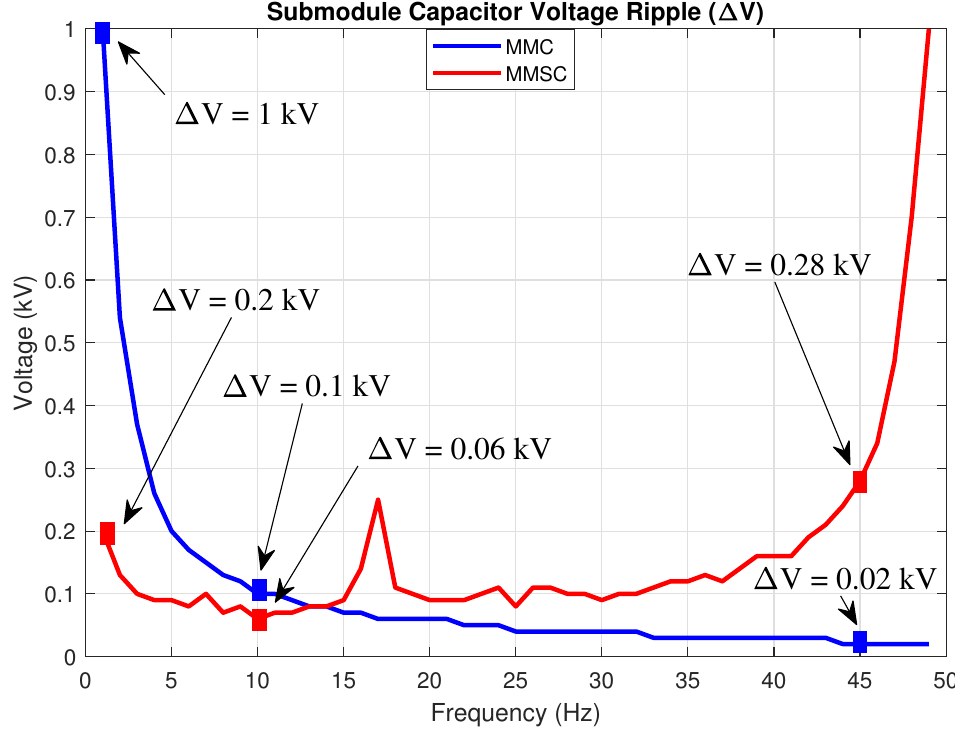
Figure 4. Submodule-capacitor voltage ripple of MMC and MMSC for the frequency range from f o = 1 Hz to f o = 49